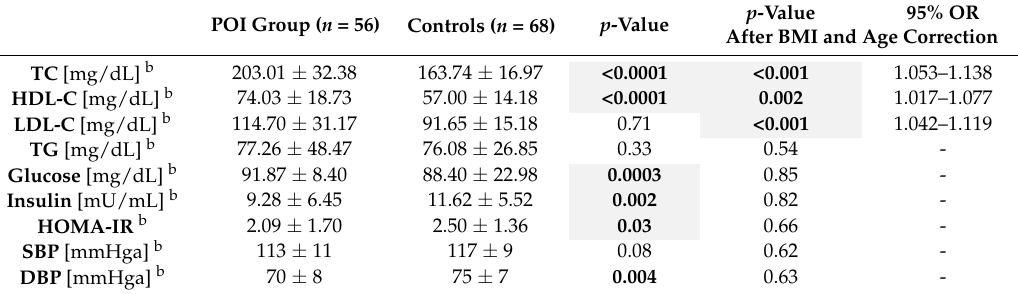
Table 2. Metabolic parameters in women with POI and healthy controls. Data shown as cholesterol; HDL-C—high-density lipoprotein cholesterol; LDL-C—low-density lipoprotein cholesterol; TG—triglycerides; HOMA-IR—Homeostatic Model Assessment-Insulin Resistance; SBP—systolic blood pressure; DBP—diastolic blood